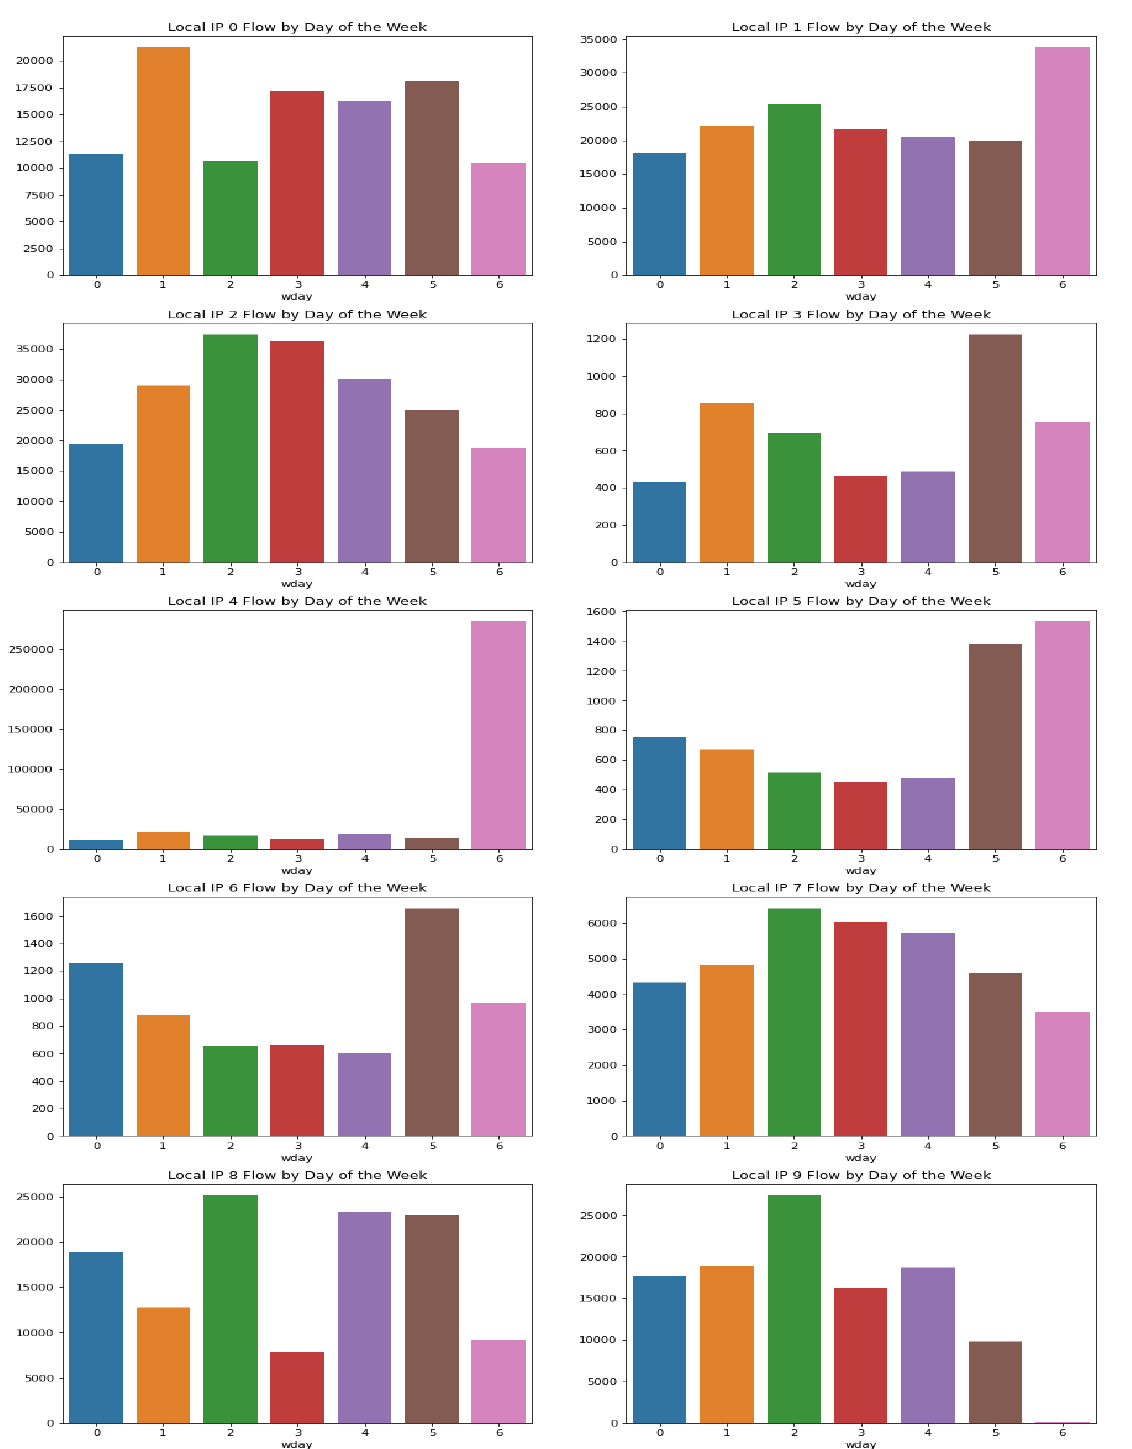
Figure 2. The flow of IP by day of the week.